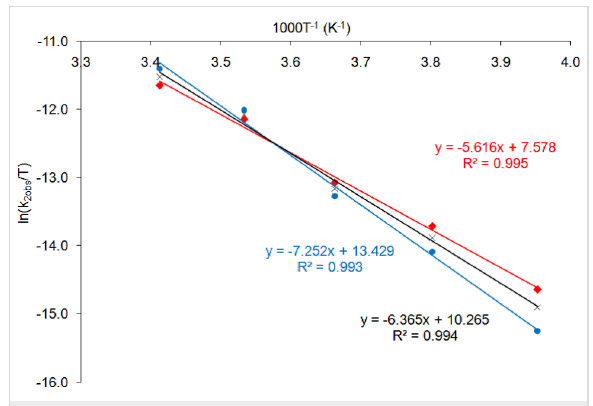
Figure 4: Eyring plot to determine the activation parameters for cata- lyst 2 in propylene carbonate. The red and blue data and best-fit lines correspond to the two individual data sets given in Table 4. The black data and best-fit line correspond to the average data.